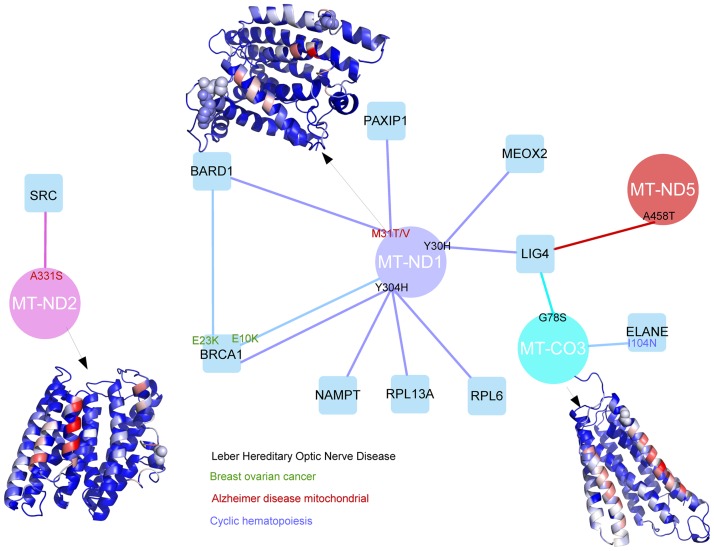
LHON interaction network with disease-related nsSNPs located at modeled protein-protein interfaces.Proteins associated with LHON pathology (circles) and their modeled interactions (edges) with other proteins of the network (squares), showing the disease nsSNPs (for LHON and other pathologies) that are located at the modelled protein-protein interfaces. The homology-modeled structures for selected proteins are shown in ribbon, with disease nsSNPs in CPK representation, and all residues colored according to their NIP value (in red NIP > 0.2; in blue NIP < 0.0).